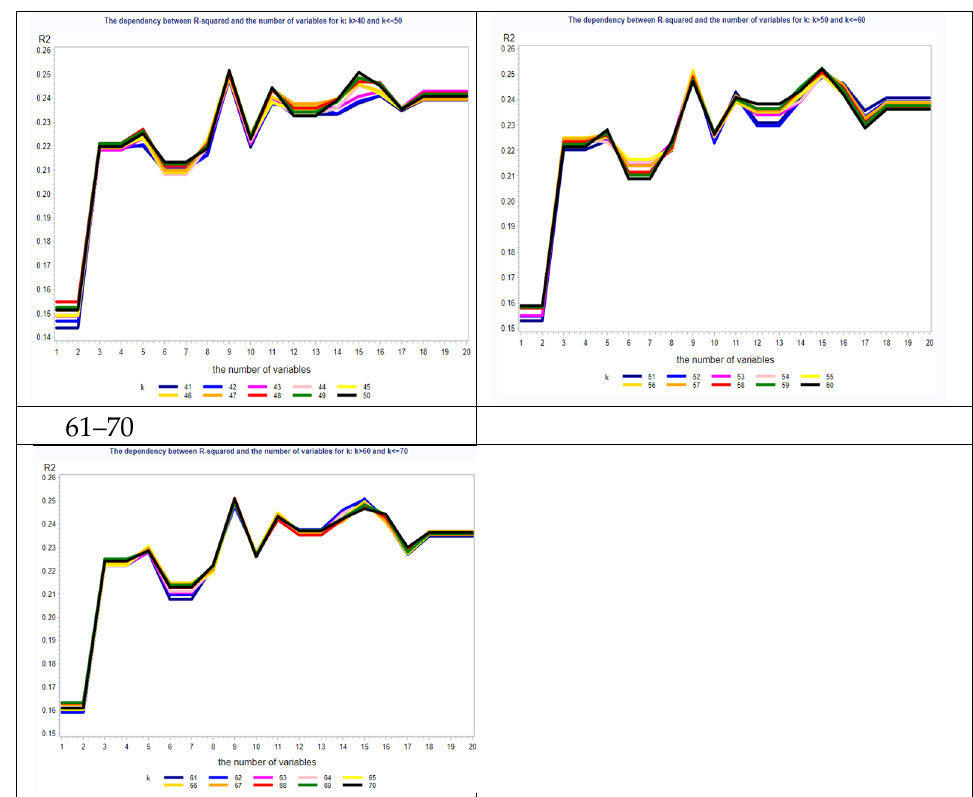
Figure 1. Results of discriminatory power of the model split by the number of neighbors in the batches.